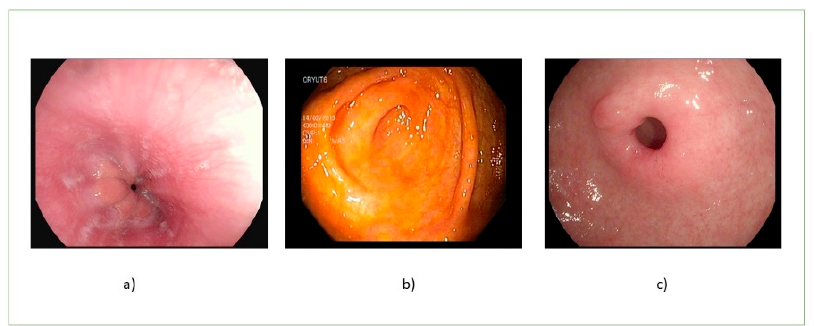
Figure 1. Normal images: ( a ) normal z-line, ( b ) normal cecum, and ( c ) normal pylorus.